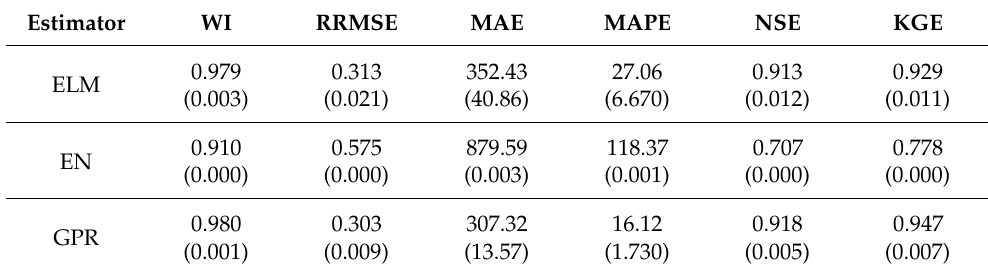
Table 9. Model results for Case